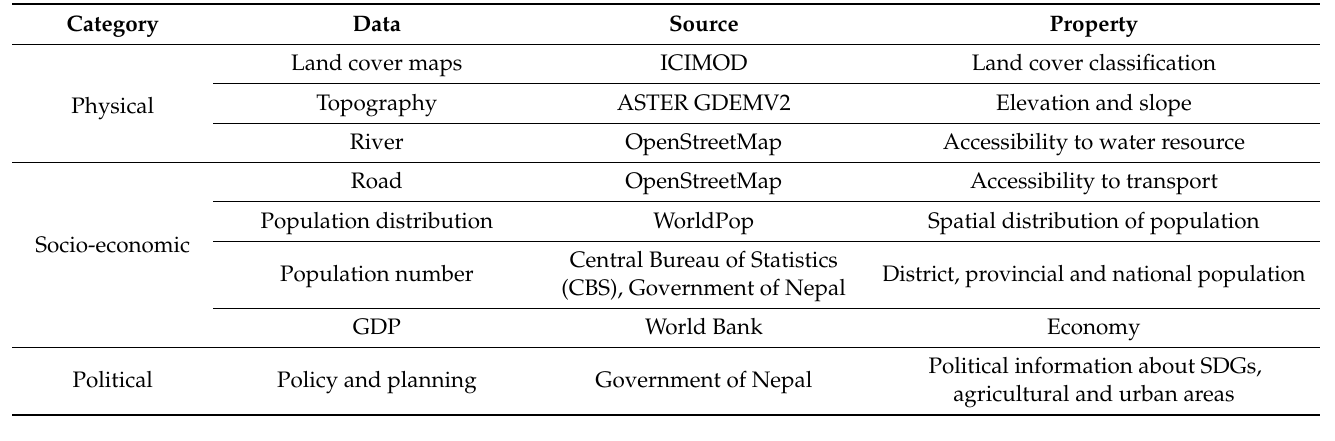
Table 1. Data utilized in the study.